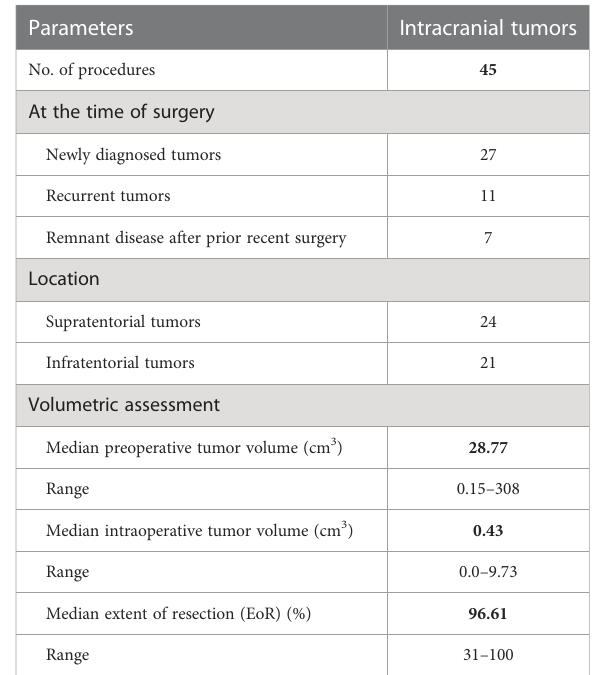
TABLE 3 Clinical and radiological aspects of group